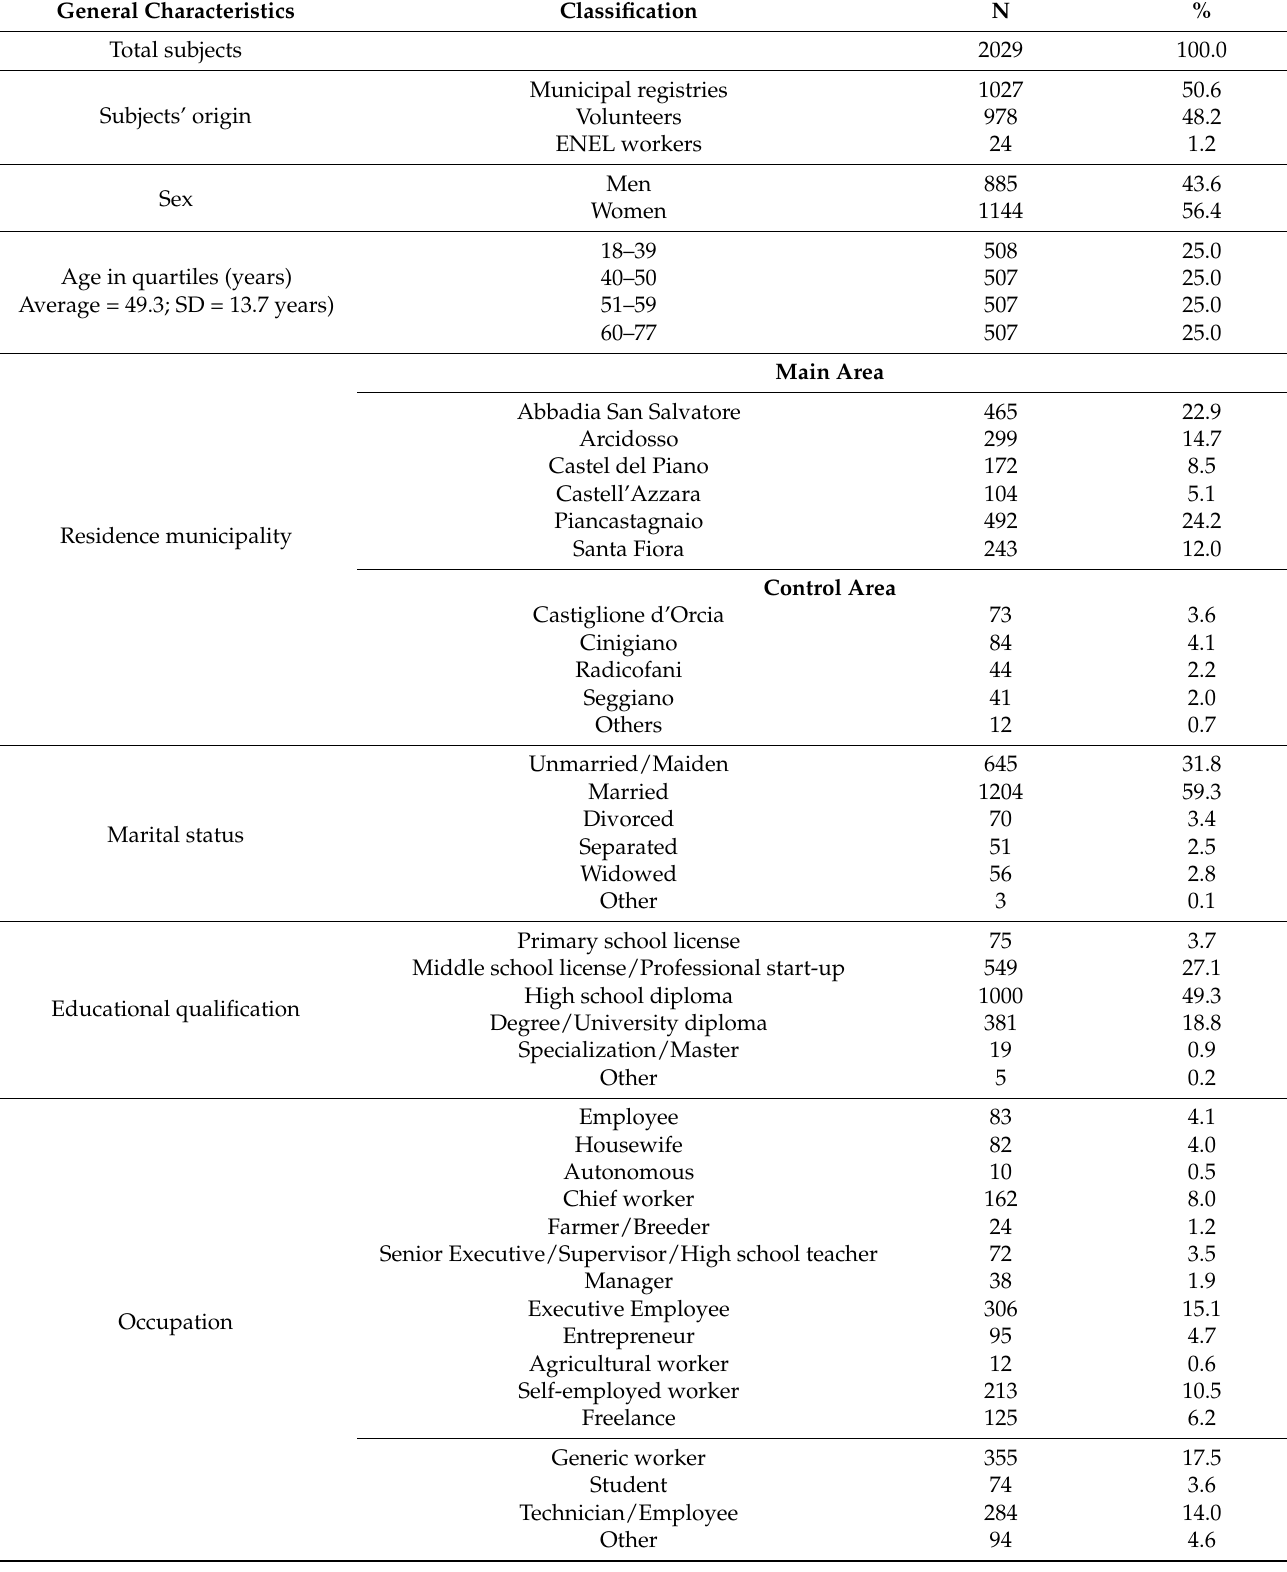
Table 2. Characteristics of the sample of respondents to the